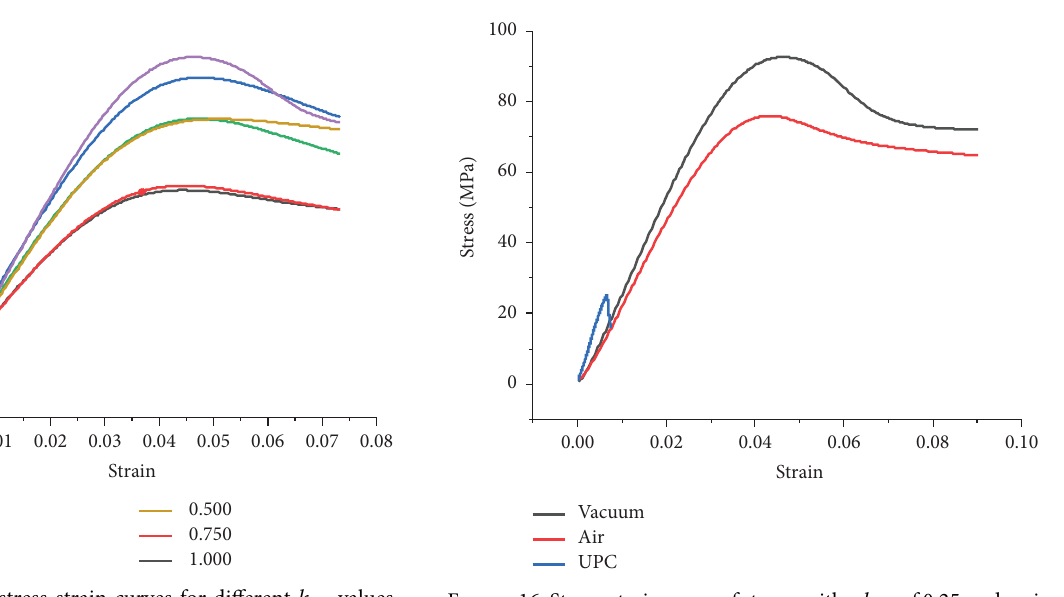
CE of 0.25 under air